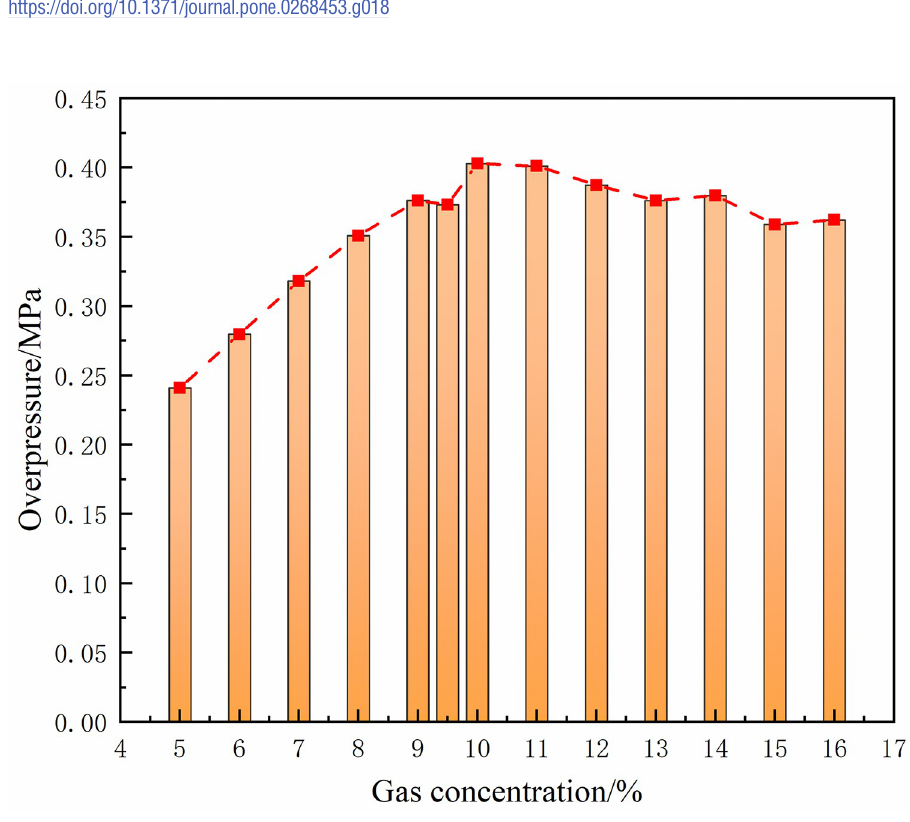
Fig 19. Pressure—Time curves and peak at monitoring point 8 at different gas concentrations (pressure peak).